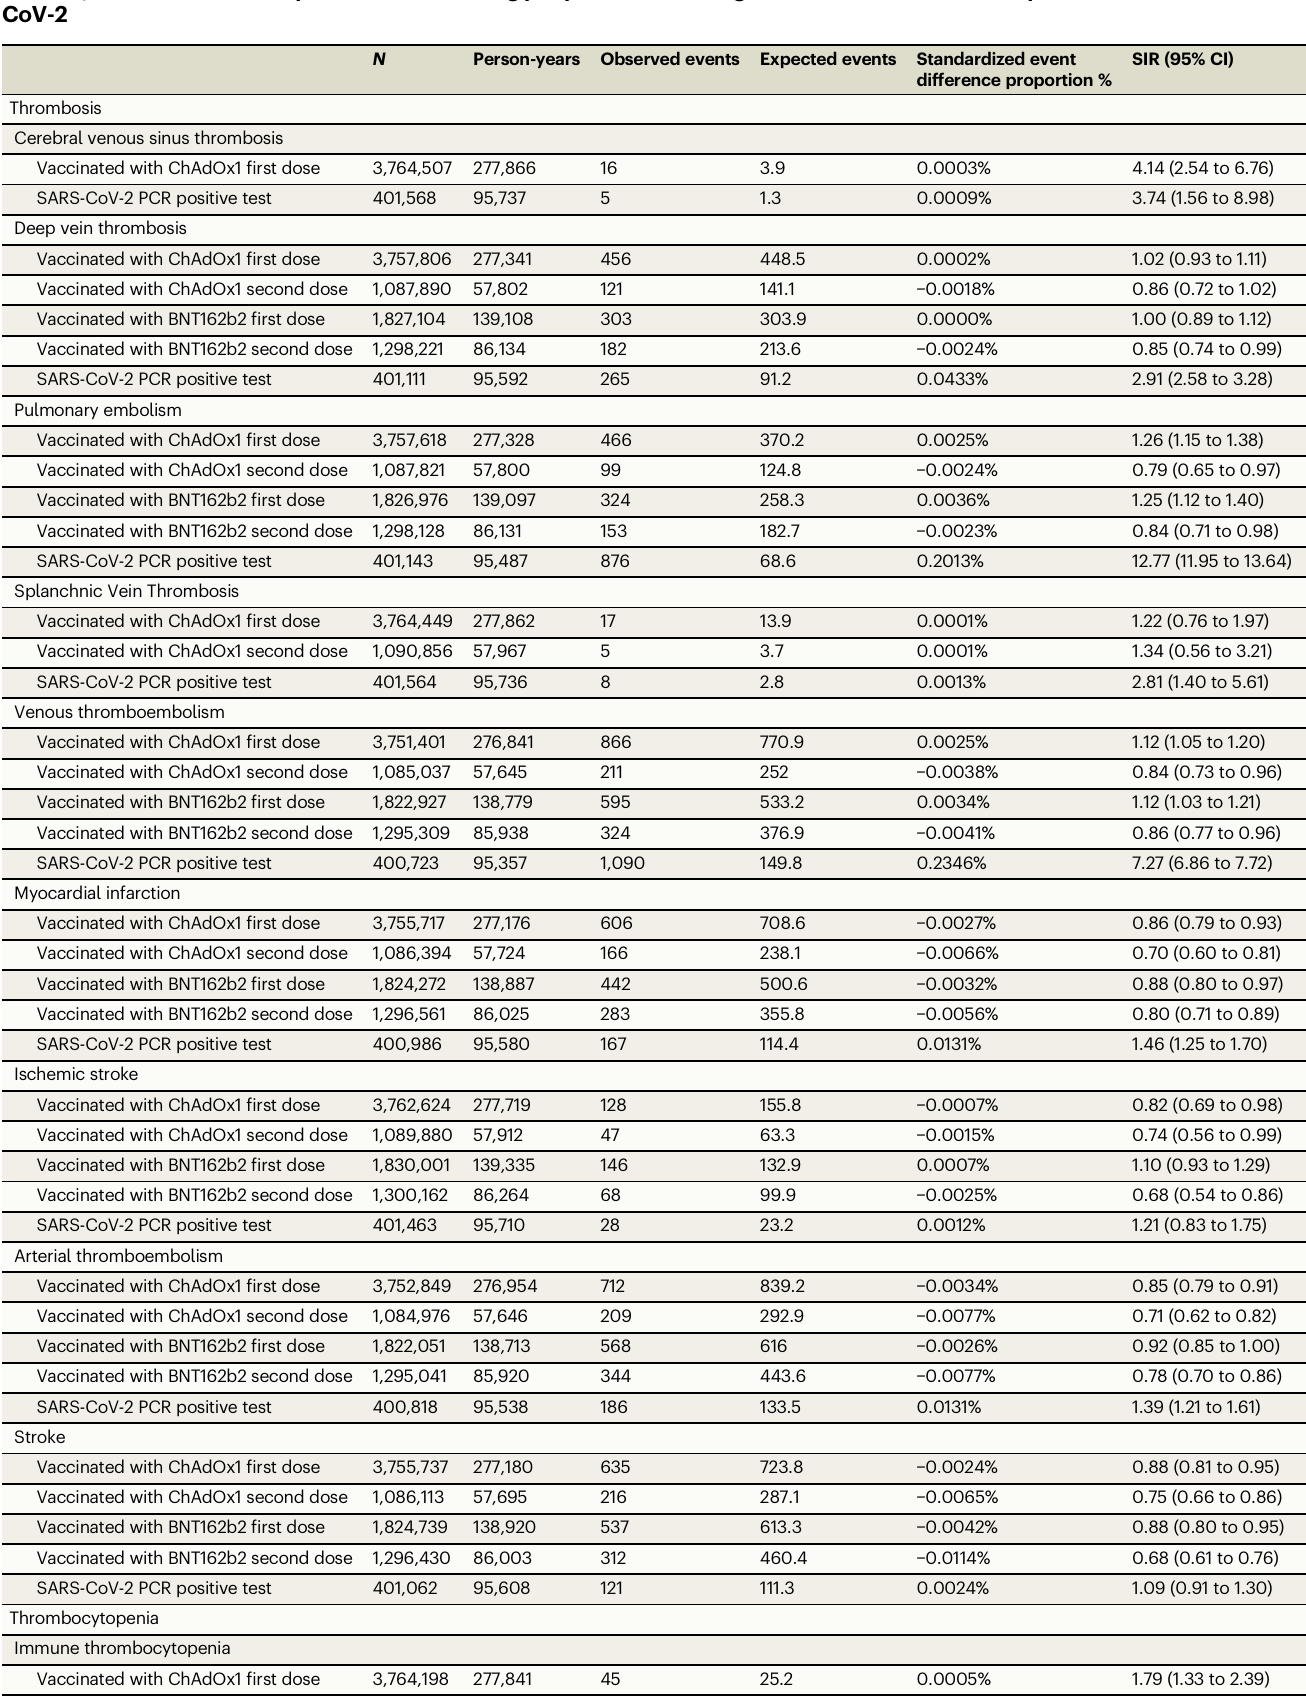
Table2|Observed versusexpected eventsamongpeoplevaccinatedagainst SARS-CoV-2orwithapositivePCRtestfor SARS-